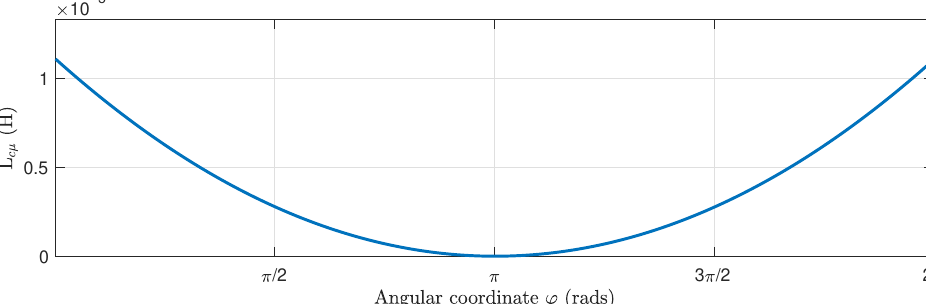
Figure 13. Number and direction of the conductors per air gap interval of a stator winding ( top ) and a rotor bar ( bottom ).